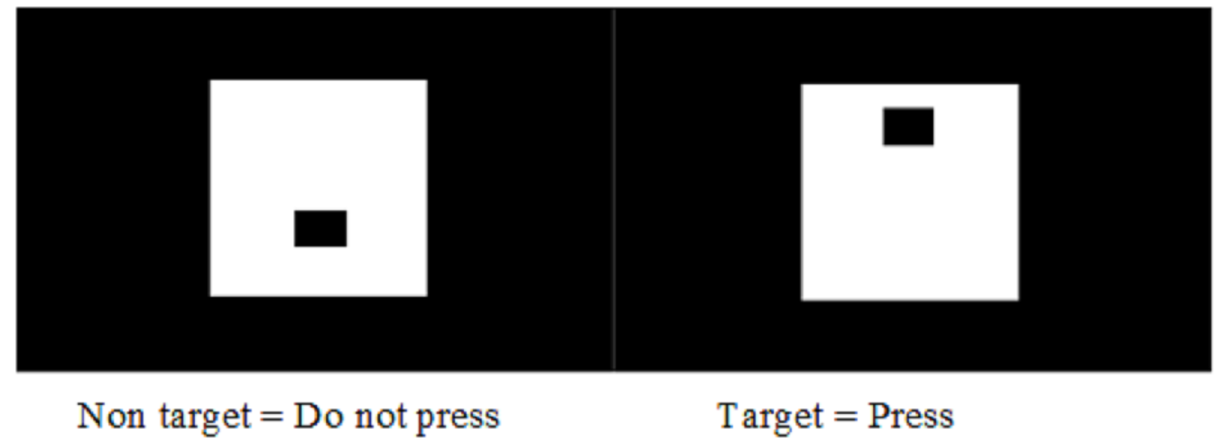
Fig 1. Indication of non target and target in visual TOVA.